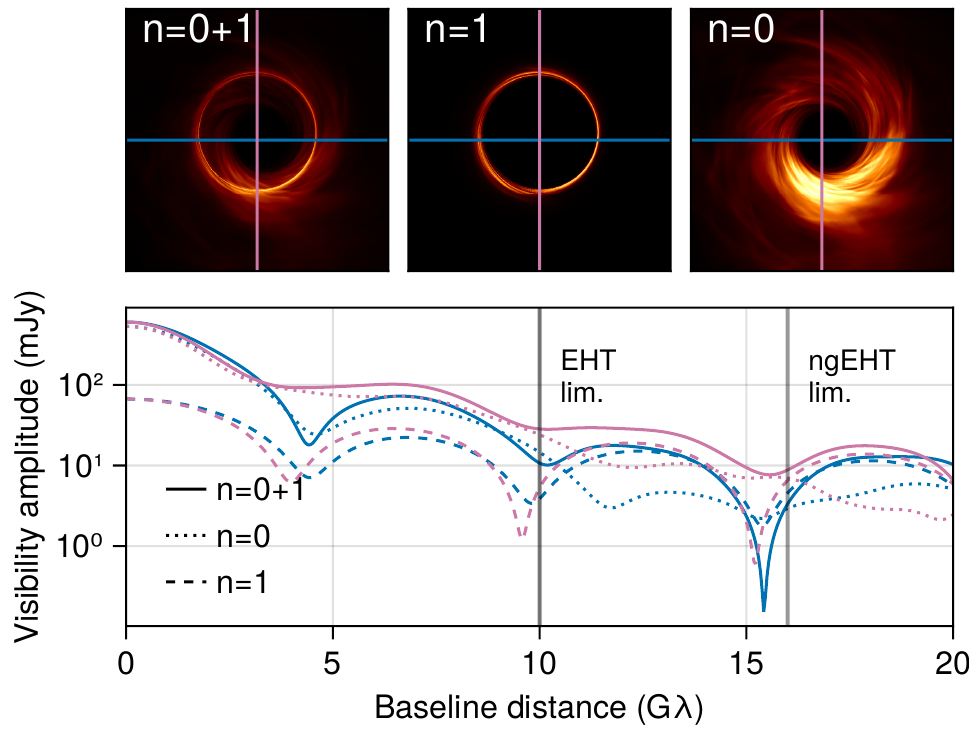
Figure 1. The image of a black hole can be decomposed into subimages that are indexed by the number of half orbits that their photons traveled around the black hole before reaching the observer. In this scheme, the n = 0 emission (top right panel) is the “direct” image of the accretion flow and is dominated by astrophysical emission structure. The n = 1 emission (top middle panel) is the “secondary” image, consisting of photons that have traveled a half orbit around the black hole before reaching the observer. The actual observed image is a sum of all n subimages (top right panel). The bottom panel shows visibility amplitudes of these (sub)images for projected baselines that are parallel (blue) and perpendicular (pink) to the black hole spin axis. The longest EHT and ngEHT baselines, indicated with vertical black lines, occur at baseline lengths for which the n = 0 and n = 1 contributions are comparable, raising the prospect of distinguishing them through